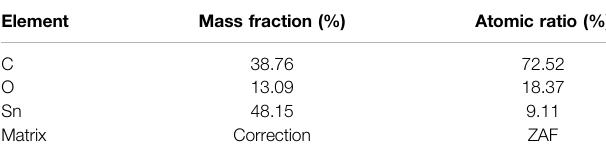
TABLE 1 | Element content of SnO 2